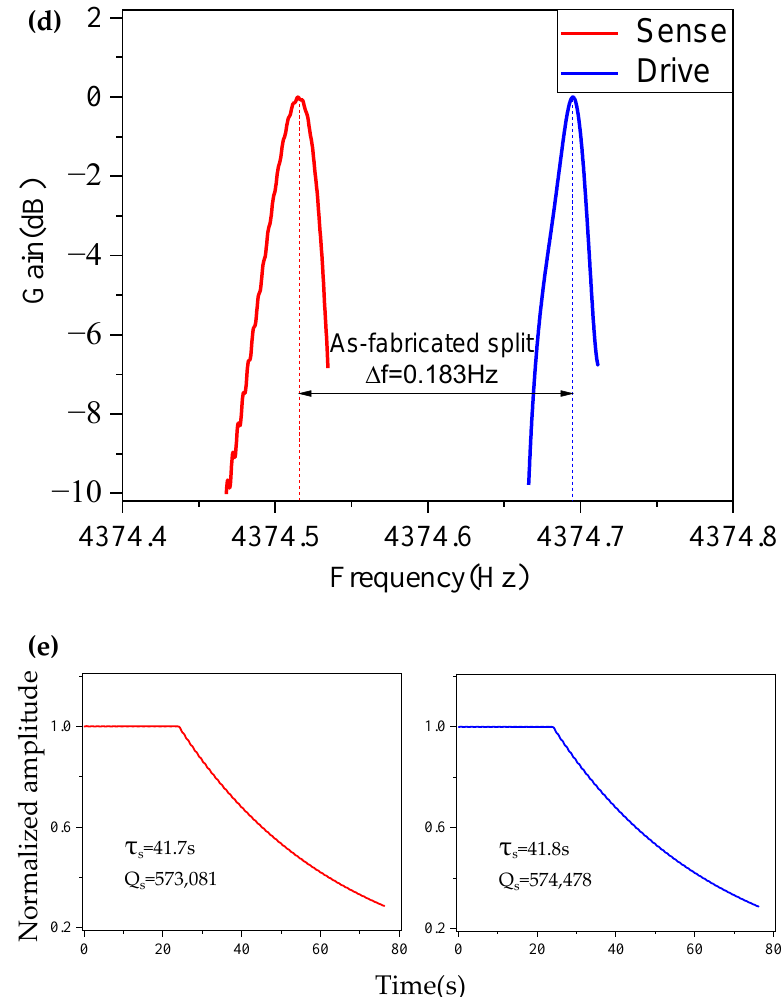
Figure 1. ( a ) Honeycomb disk resonator gyroscope structure. ( b ) Schematic diagram of the mode. ( c ) SEM image of the HDRG. ( d ) Resonant frequency and initial frequency difference of driving mode and sensing mode. ( e ) Ring-down curves of the driving and sensing modes of the HDRG.